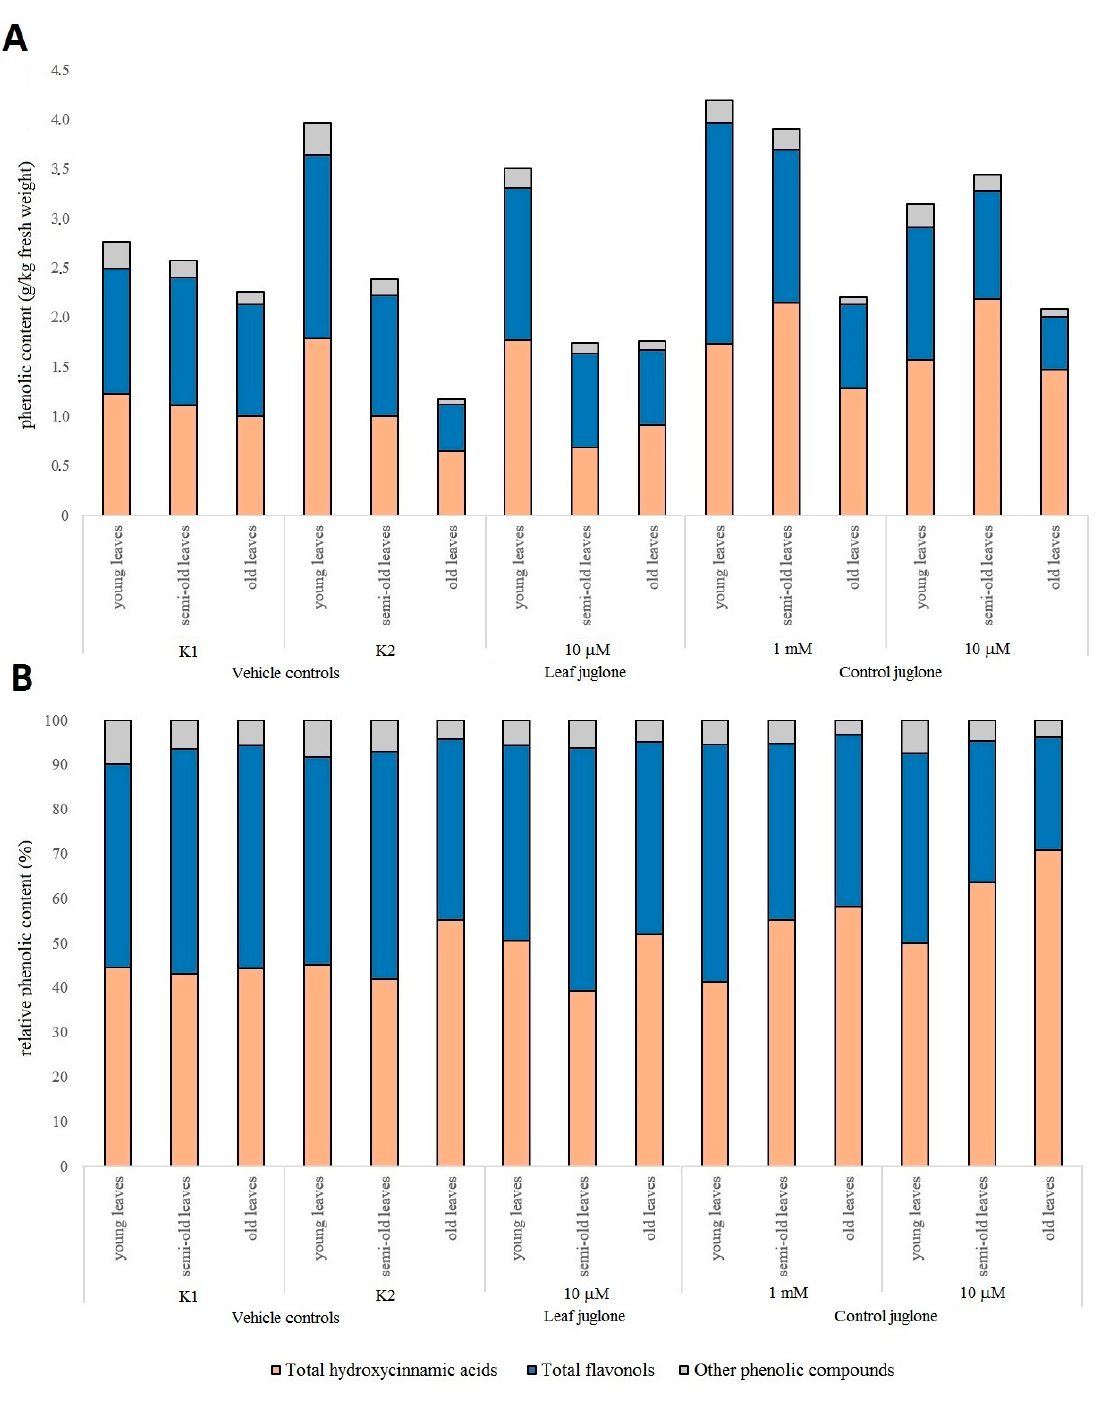
Figure 3. Contents of the total phenolic groups identified in B. rapa var. japonica expressed relative to fresh weight ( A ) and as proportions of the total phenolic groups identified ( B ). K1: extraction medium control (0.17% DMSO, 0.17% ethanol in H 2 O); K2: water control. Young leaves, undeveloped leaves; semi-old leaves, remaining fully developed leaves; old leaves, four outer fully developed leaves.